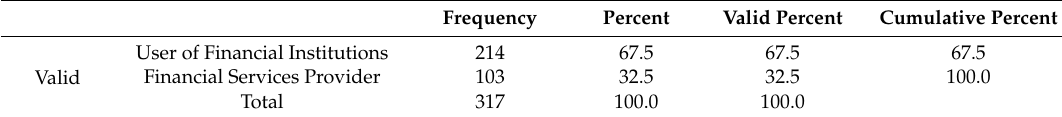
Table A5. Provider–user.